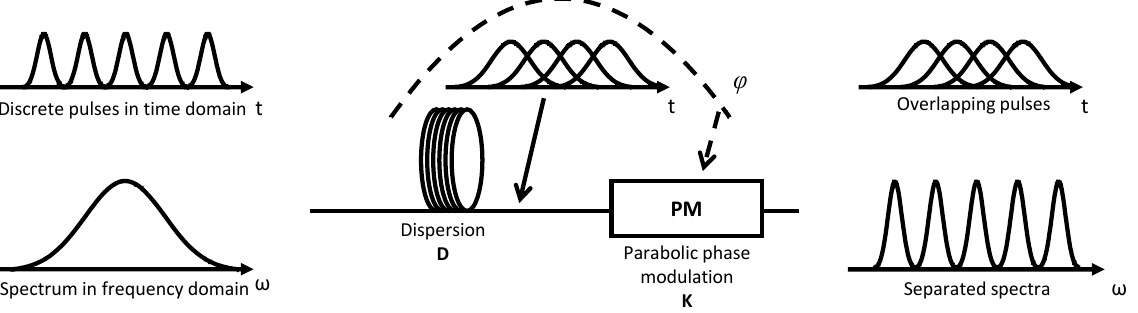
Figure 6. Principle of optical Fourier transformation (OFT) for transferring short pulses in the time domain into separated spectra in the frequency